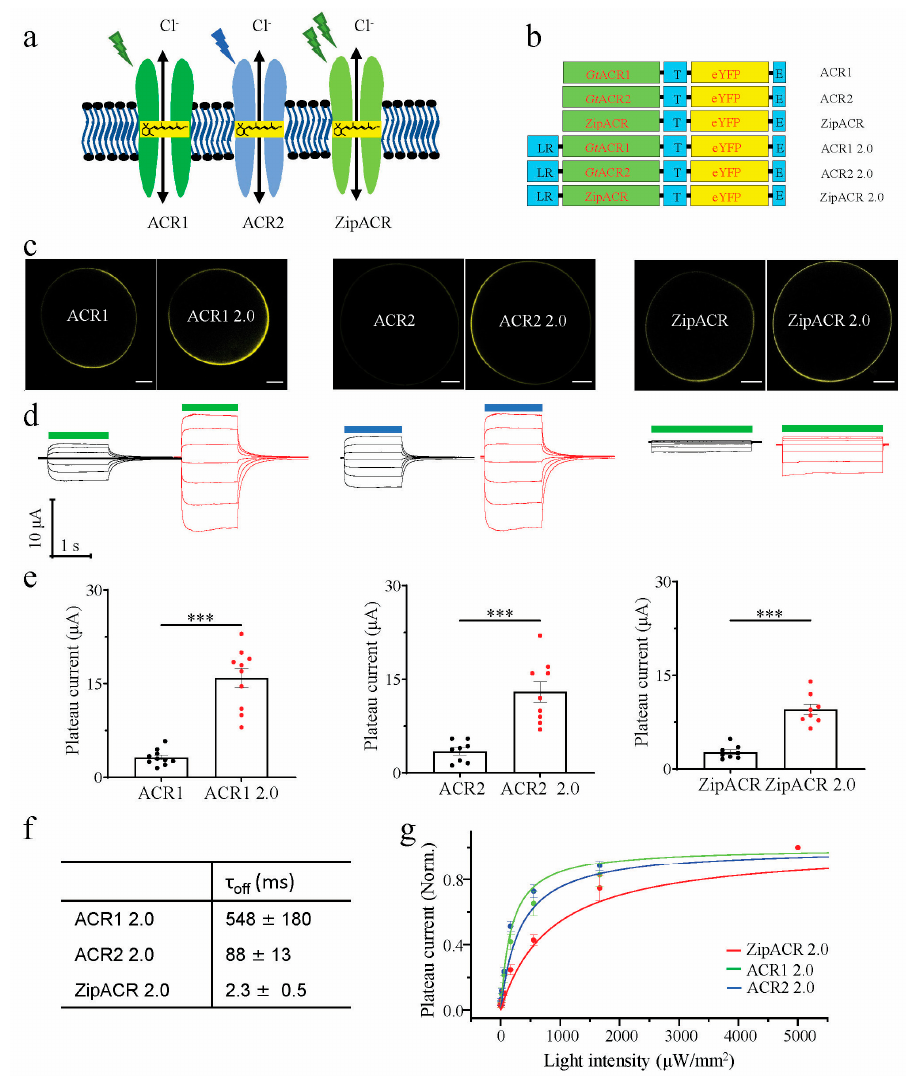
Figure 1. Characterization of engineered ACRs in Xenopus laevis oocytes. ( a ) Schemes of the anion channelrhodopsins conducting chloride ions; the chromophore all-trans-retinal is indicated in the yellow frame. ACR1 is green light-activated, ACR2 is blue light-activated, and ZipACR needs green light of higher qunatity to be activated. ( b ) Scheme of the ACR1, ACR1 2.0, ACR2, ACR2 2.0, ZipACR, and ZipACR 2.0 DNA constructs, LR: the LucyRho membrane targeting signal, T: plasma membrane trafficking signal, E: ER export signal peptides. ( c ) Confocal fluorescence images of oocytes expressing YFP-fusions of ACR1, ACR1 2.0, ACR2, ACR2 2.0, ZipACR, and ZipACR 2.0 (n = 3), scale bar = 200 µm. ( d ) Representative photocurrent traces of ACR1, ACR1 2.0, ACR2, ACR2 2.0, ZipACR, and ZipACR 2.0 measured by two-electrode voltage- clamp (TEVC) in oocytes. Holding potentials during voltage-clamp pulse protocols were from − 90 mV to 30 mV (from bottom to top) in 20 mV increments, green bar represents green light (532 nm, 100 µW/mm 2 ) illumination and blue bar represent blue light (473 nm, 100 µW/mm 2 ) illumination. ( e ) Comparison of the light-induced photocurrents of ACR1(n = 10), ACR1 2.0 (n = 10), ACR2 (n = 8), ACR2 2.0 (n = 8), ZipACR (n = 8), and ZipACR 2.0 (n = 8) in oocytes, the statistical significance was analyzed by Student’s T-Test, ACR1 versus ACR1 2.0, p = 2.4 × 10 − 6 , ACR2 versus ACR2 2.0, p = 1.3 × 10 − 4 , ZipACR versus ZipACR 2.0, p = 4.0 × 10 − 6 , Error bars = s.e.m. ( f ) Channel closing kinetics ( τ off ) was determined by a single exponential fit with Clampfit 10.7, for ACR1 2.0, τ off = 548 ± 180 ms, for ACR2 2.0, τ off = 88 ± 13 ms, for ZipACR 2.0, τ off = 2.3 ± 0.5 ms. Data were obtained from measurements at − 70 mV and shown as mean ± s.e.m, n = 3. ( g ) Comparison of the light sensitivity of ACR1 2.0 (n = 6), ACR2 2.0 (n = 5) and ZipACR 2.0 (n = 5). Error bars = s.e.m. For ACR1 2.0, EPD 50 = ~180 µ W/mm 2 , for ACR2 2.0, EPD 50 = ~320 µ W/mm 2 , and for ZipACR 2.0, EPD 50 = ~830 µ W/mm 2 . For each cell, the data points at different light intensities were divided by the photocurrent recorded under the highest light intensity (5000 µ W/mm 2 ) for normalization. ***, p ≤